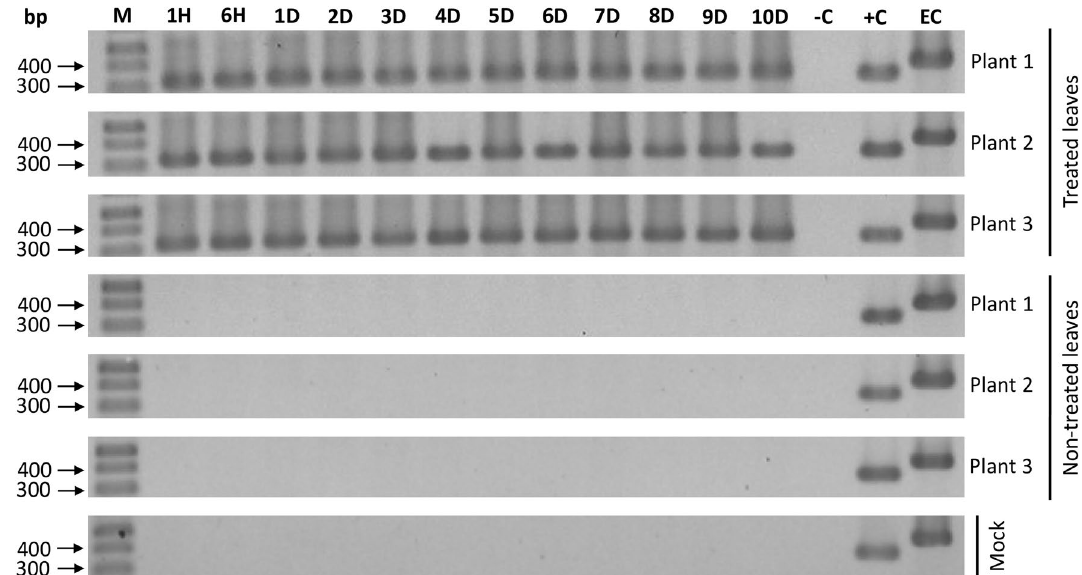
Figure 6. RT-PCR detection of long-dsRNA homologous to tomato mosaic virus (ToMV) sequence in treated and non-treated (younger leaf above the dsRNA application site) leaves of tomato plants at different time points after dsRNA application [1 and 6 h (H), daily from 1 to 10 days (D)] is shown on 1.2% agarose gel electrophoresis. M: molecular weight DNA ladder (1 Kb plus DNA ladder, Thermo Fisher Scientific). –C: